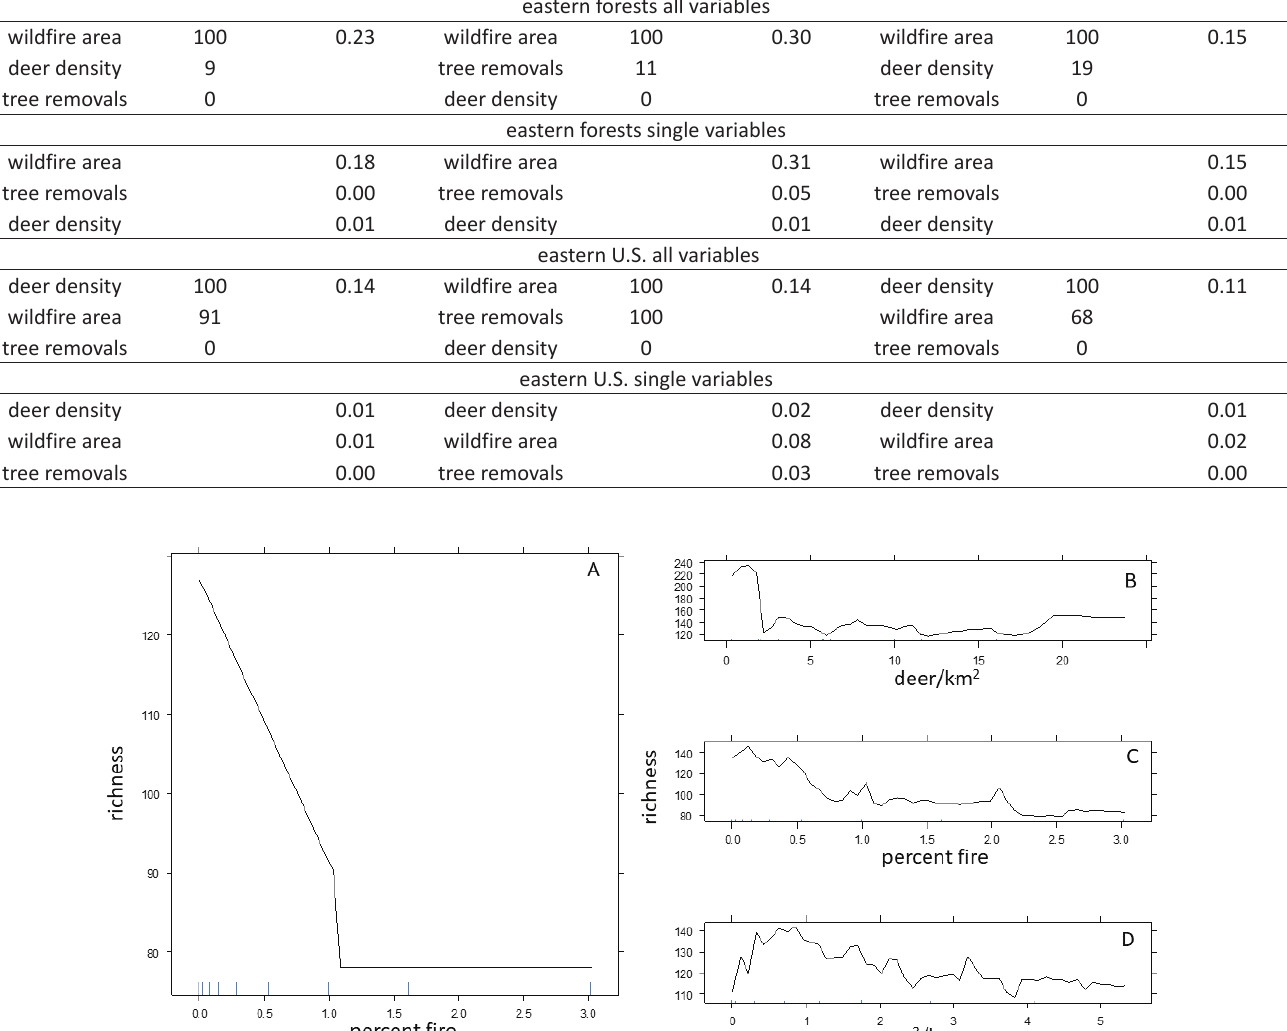
Landscape Online – supported by the International Association for Landscape Ecology and its community